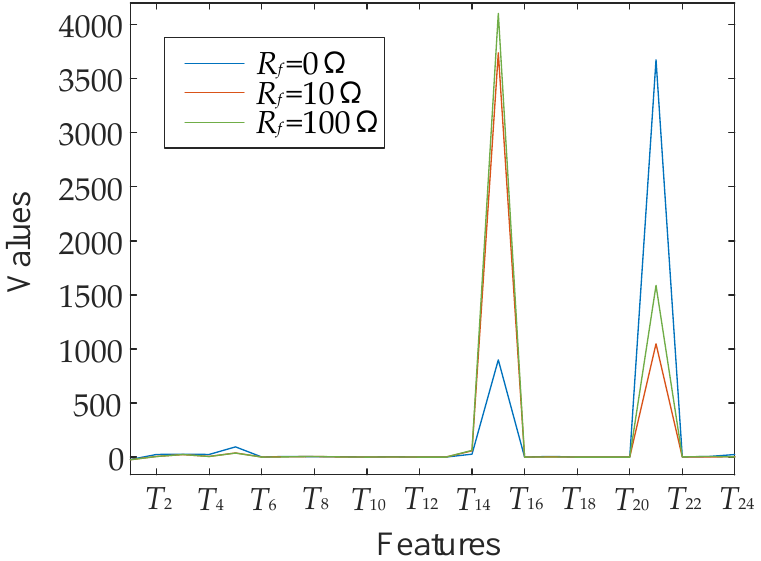
Table 5. Fault features and values with fault resistance.